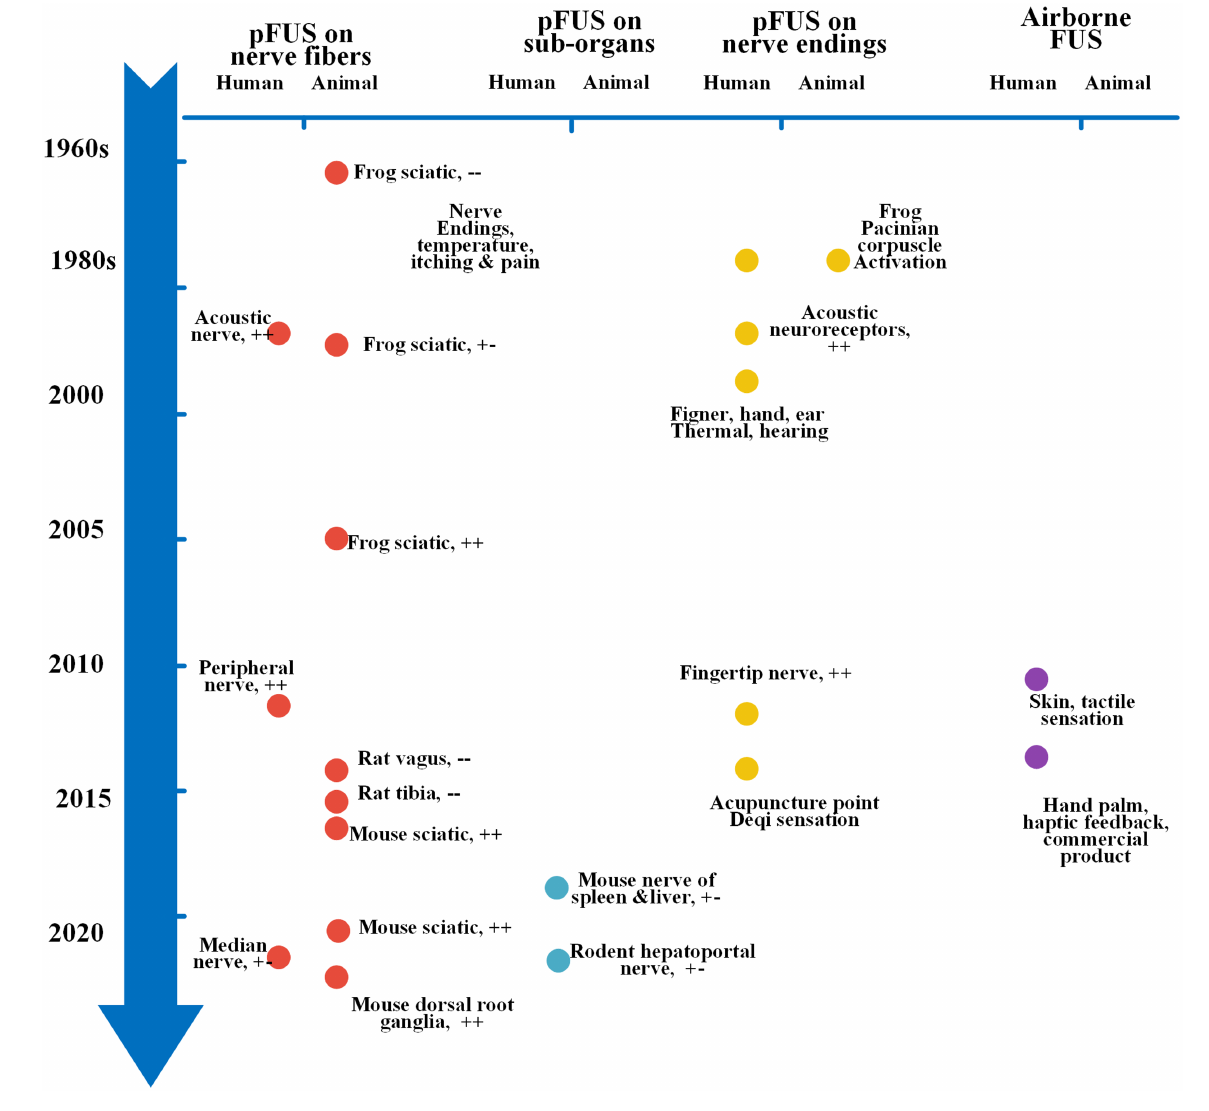
FIGURE 2 Timeline and brief history of representative pFUS applications. Each dot represents one typical finding, different color indicates different stimulation applications, left side for animal studies, right side for human studies. y -axis, year in sequence, before 2000, each tick means 20 years, after 2000, each tick means 5 years; x -axis, different pFUS techniques. pFUS, peripheral focused ultrasound stimulation. ++, excitation; + − , modulation or mixed effects; − –,